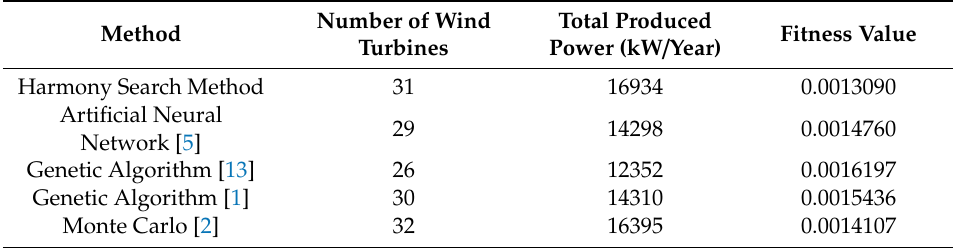
Table 2. Harmony search method results.